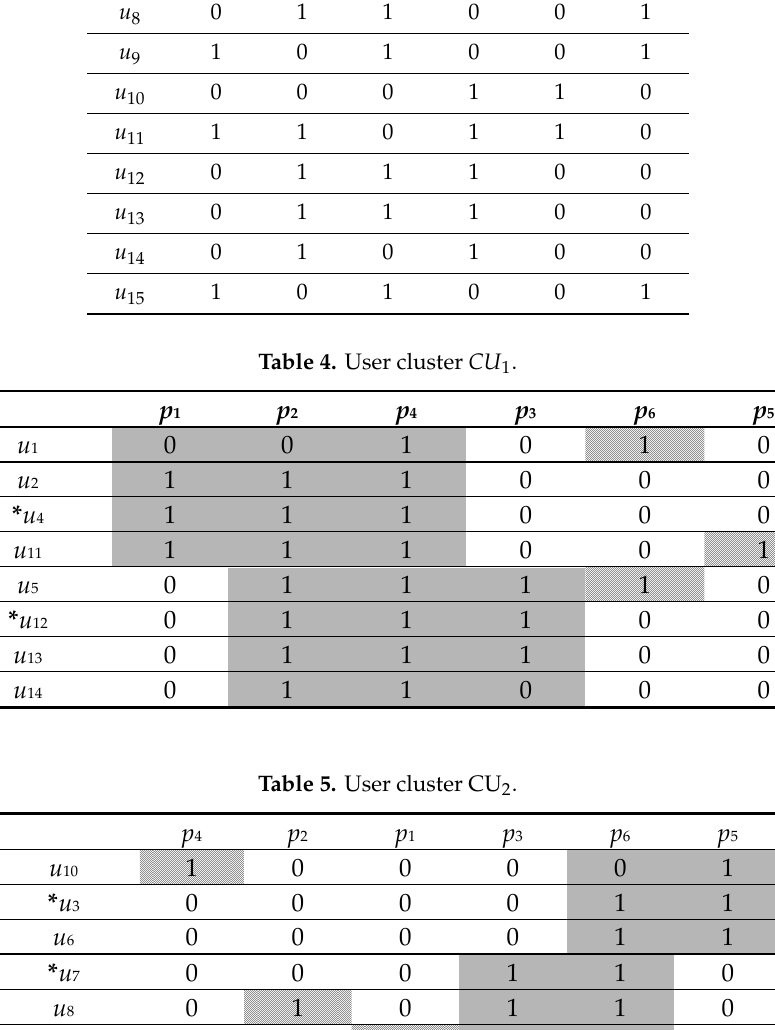
Table 3. Original matrix UPA original.